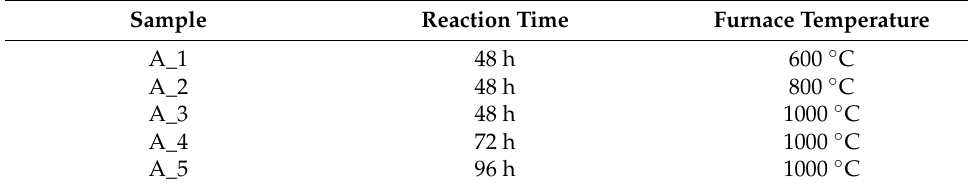
Table 1. Test matrix with the thermal treatment conditions used for each sample.